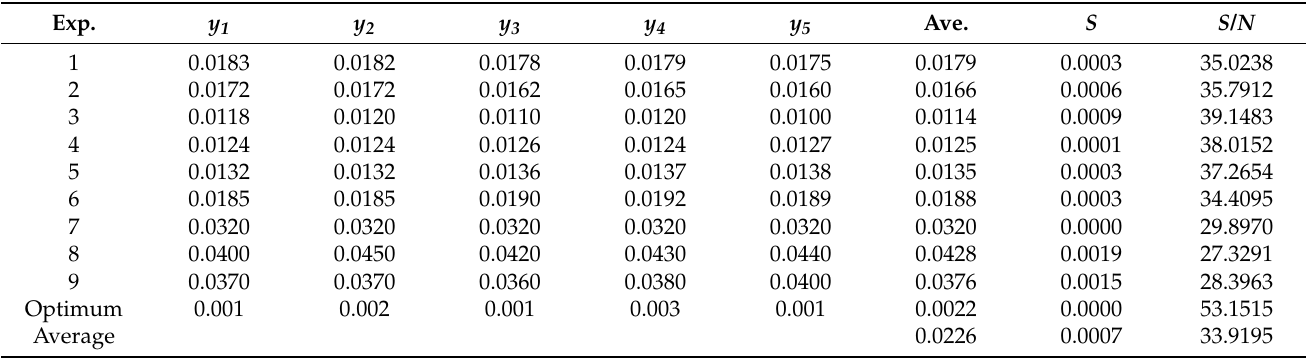
Table 3. S/N ratio of warpage of base part for the MAV.